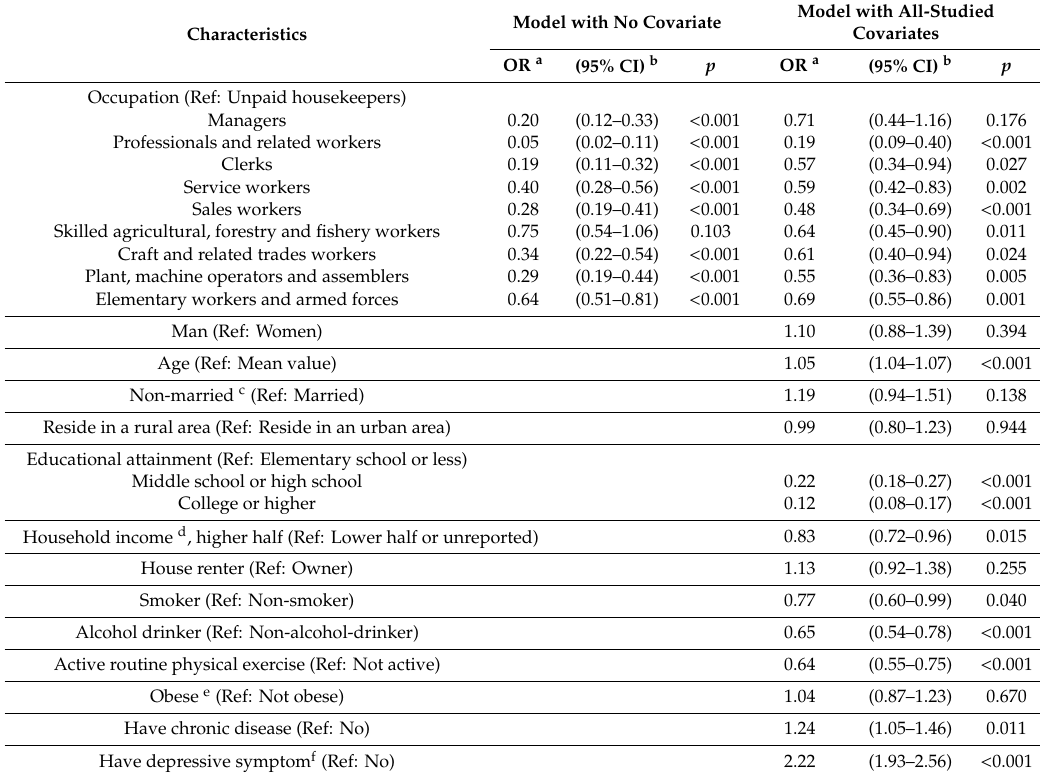
Table 3. Longitudinal analyses of the associations of occupation categories with cognitive